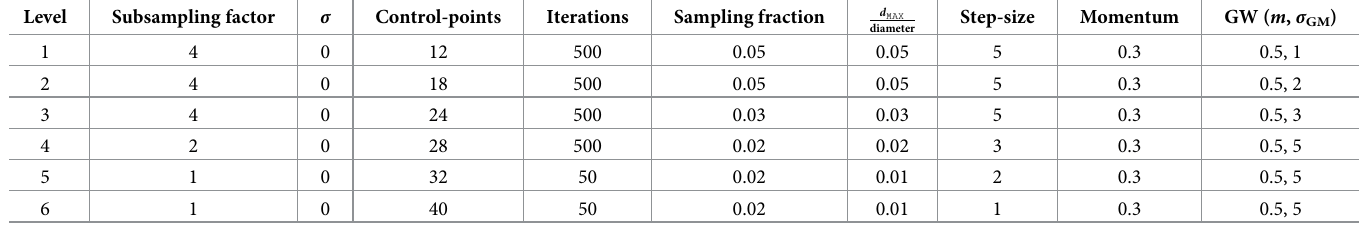
Table 2. INSPIRE parameter configuration for evaluation on retinal images from the FIRE dataset. For all levels: λ = 0.01, N α = 31, normalization percentile q = 0.1% and histogram equalization disabled. KD-tree search approximation constants are chosen as β = 1.2 and d t = 20. Level Subsampling